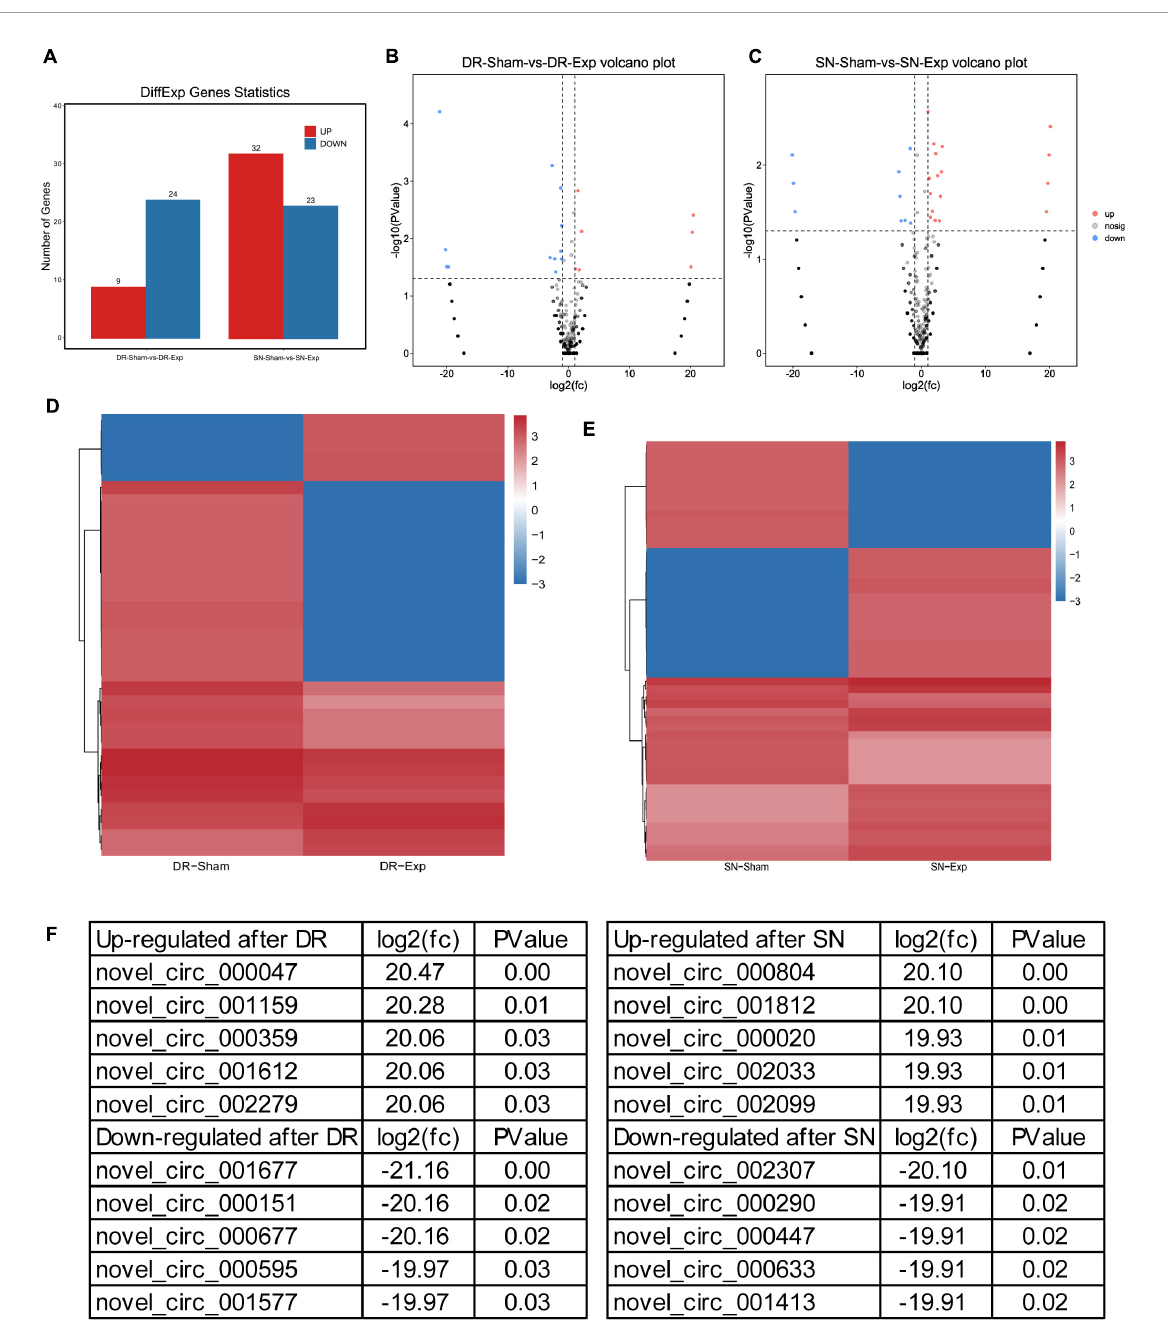
reduced novel_circ_000290 and novel_circ_001817 expression, and central axon injuries induced novel_circ_000290 expression ( Figure 3 ).